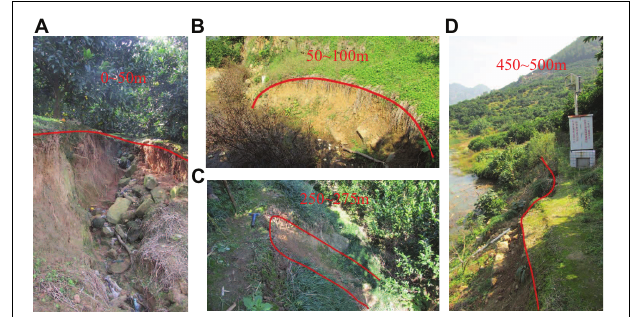
FIGURE 13 | Deformations along the optical fiber line; (A) 0 ∼ 50 m, (B) 50 ∼ 100 m, (C) 250 ∼ 275 m, and (D) 450 ∼ 500